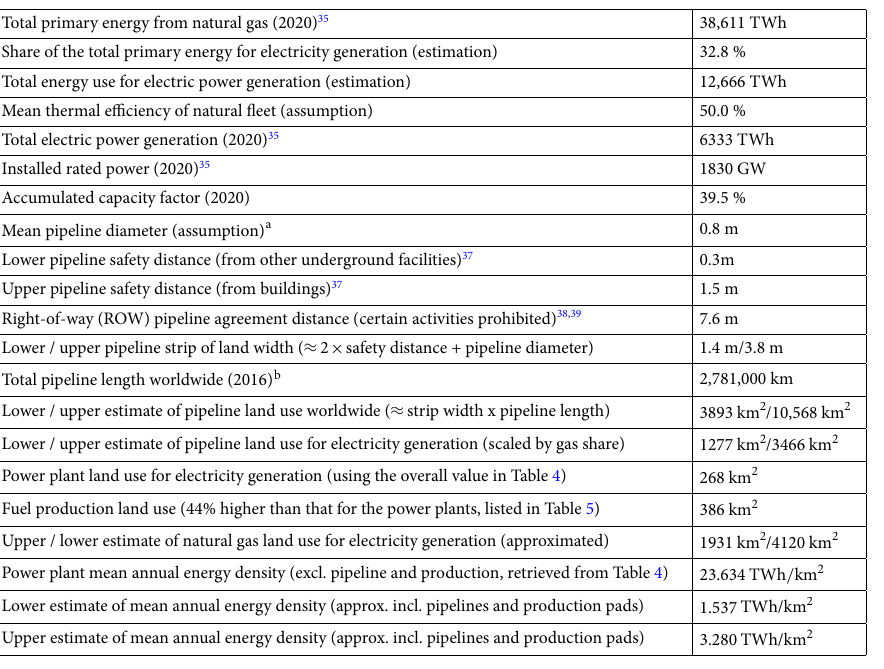
Table 6. Data needed to calculate the annual energy density including the land use of pipelines (final result at the bottom). The assessment is based on 2020 thermal electricity generation from natural gas, where the length of natural gas pipelines is retrieved from available data 40 . a The pipeline diameter can range from 50.8 to 106.7 cm. b 2,004,000 km in North America, 271,000 km in the Commonwealth of Independent States (CIS), 187,000 km in Europe, 168,000 km in Asia and Oceania, 69,000 km in Latin America, 41,000 km in the Middle East, and 41,000 km in Africa 40